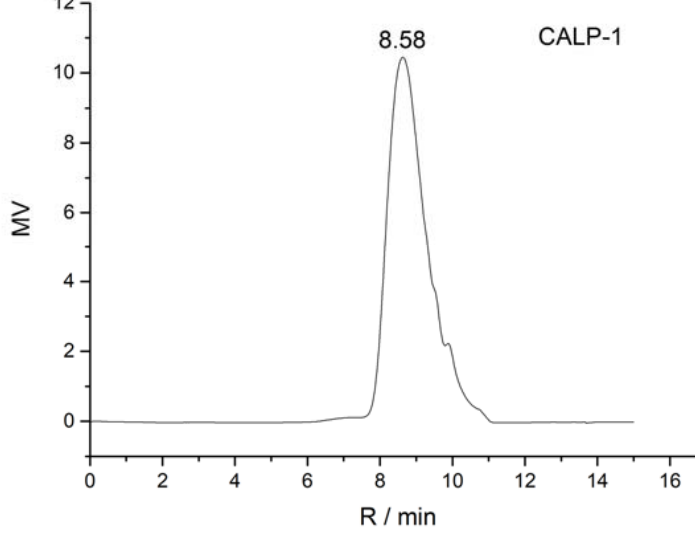
Molecules 2022 , 27 , x FOR PEER REVIEW